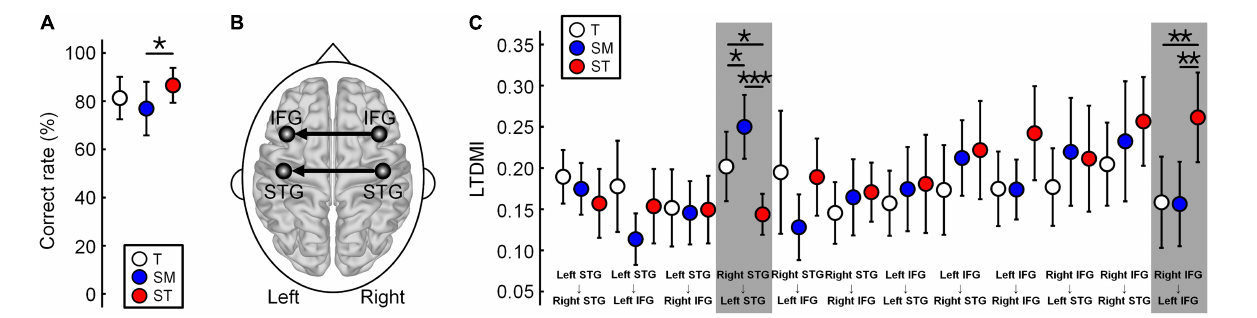
FIGURE 2 | Difference in the linearized time-delayed mutual information (LTDMI) values for the three conditions. (A) Correct rate (CR) of SM is significantly lower than the CR of ST . The other pairs are not statistically significant. * p < 0.05. (B) Difference between the conditions for LTDMI was revealed in only two interhemispheric connections, which were termed “IFG-LTDMI” and “STG-LTDMI.” (C) The STG-LTDMIs were different between all pairs. In the IFG-LTDMI, the SM was higher in the other conditions. * p < 0.05, ** p < 0.01, and *** p < 0.001 (FDR corrected). Error bars denote 95% confidence intervals. See also Supplementary Table 1 . LTDMI, linearized time-delayed mutual information; CR, correct rate; IFG, inferior frontal gyrus; STG, superior temporal gyrus; FDR, false discovery rate.